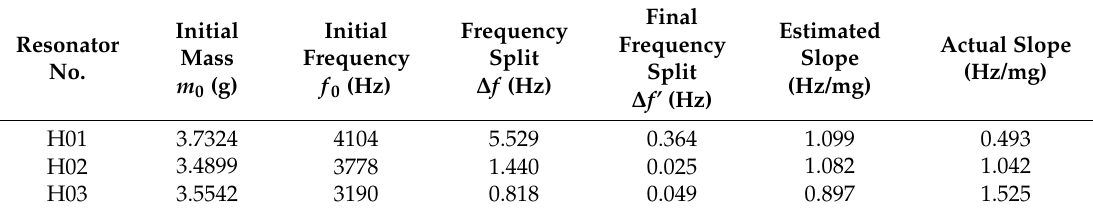
Table 4. The contrast between the estimated slope and actual slope in experiments of three resonators.